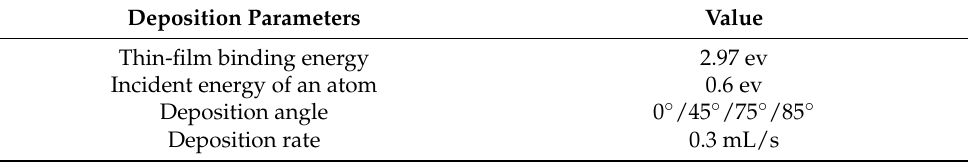
Table 2. Deposition parameters in